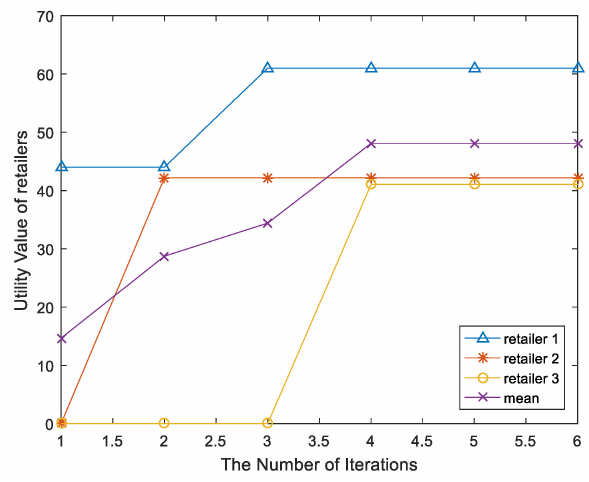
Figure 9. Utility value of retailer versus the number of iterations ( N = 32, K = 8, J =